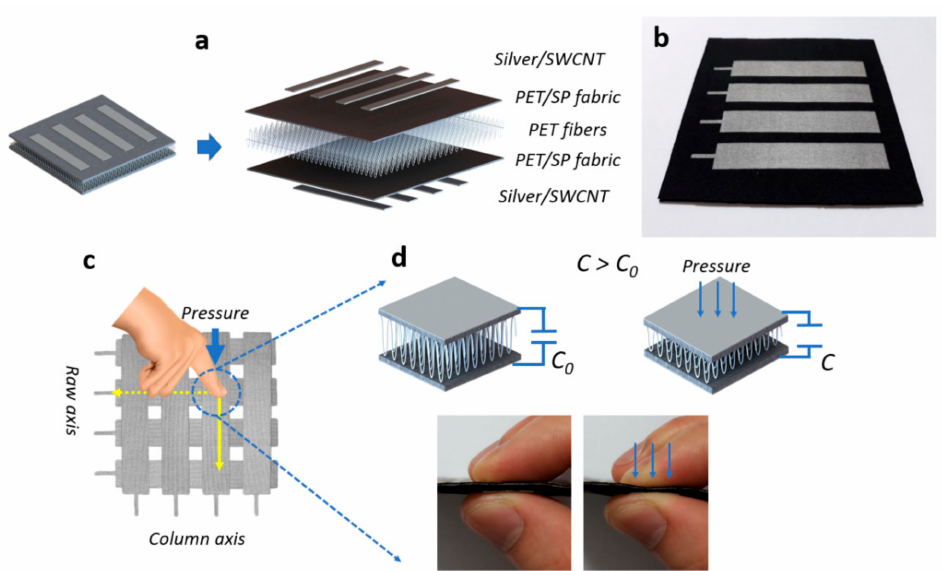
Figure 3. ( a ) Structure of the capacitive pressure sensor layer, ( b ) real picture, ( c ) working principle of the capacitive pressure sensor layer, and ( d ) working principle at the sensing